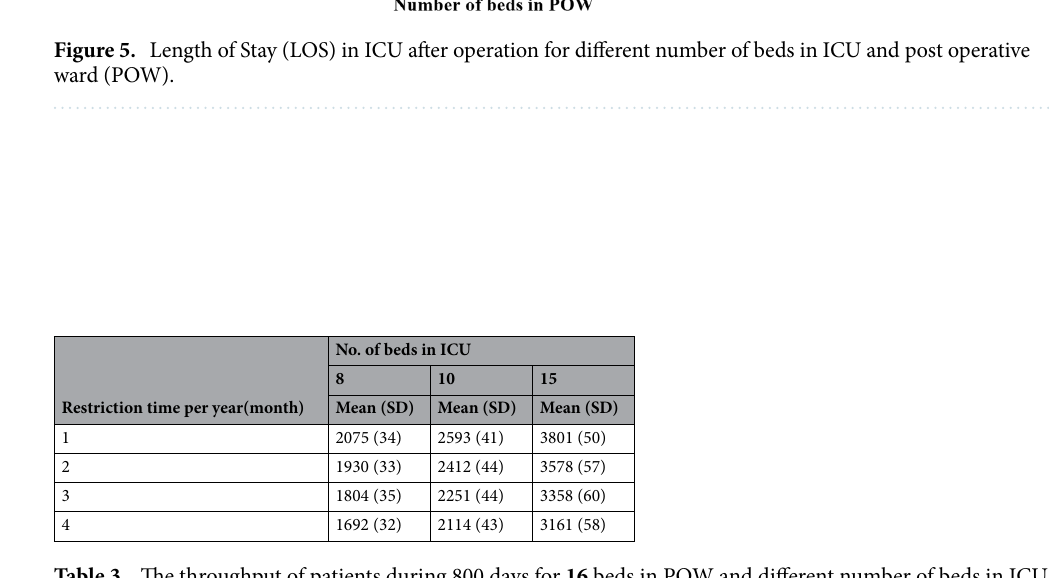
Table 3. The throughput of patients during 800 days for 16 beds in POW and different number of beds in ICU during pandemic restrictions. POW post-operative ward, ICU intensive care